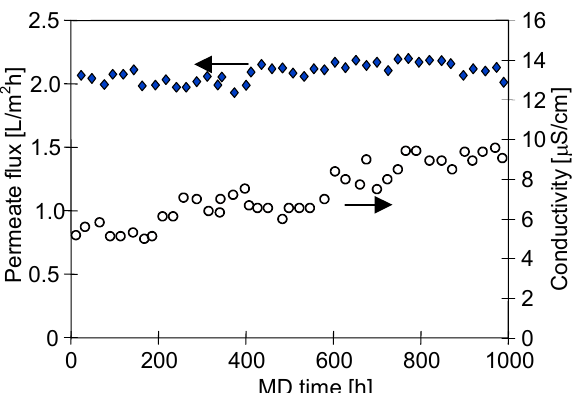
Figure 14. The changes of permeate flux and distillate conductivity during brackish water desalination. T F = 318 K. Module MK3—EuroSep PP.